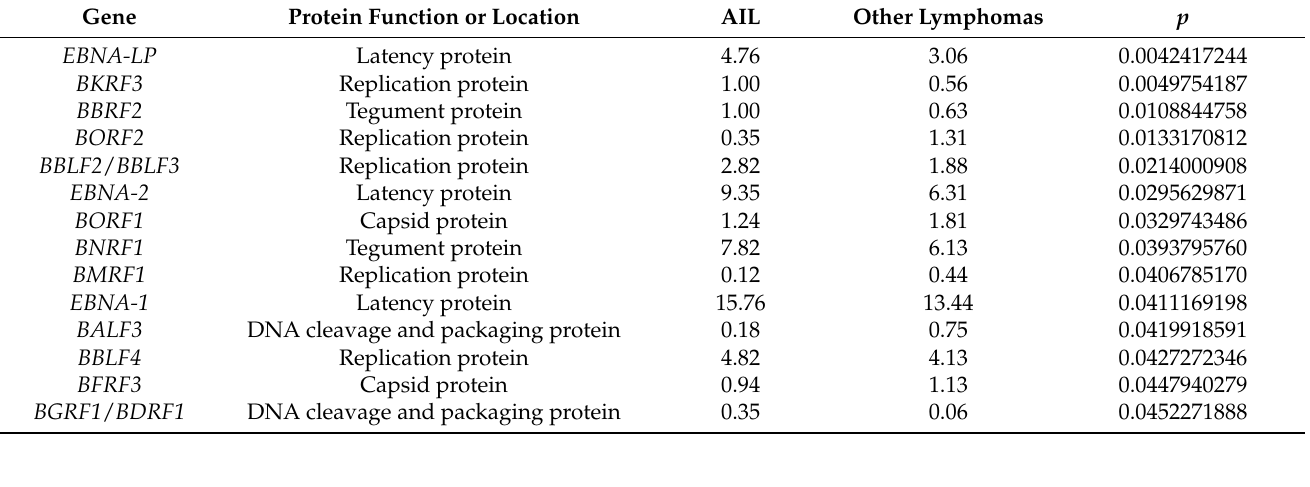
Table 5. Comparison of the Mean Number of Non-Synonymous Mutations/Gene Between the EBV “AITL” Strains and the “Other Lymphoma” Strains by the Mann-Whitney Test. Only Genes for Which p < 0.05 Were Reported.